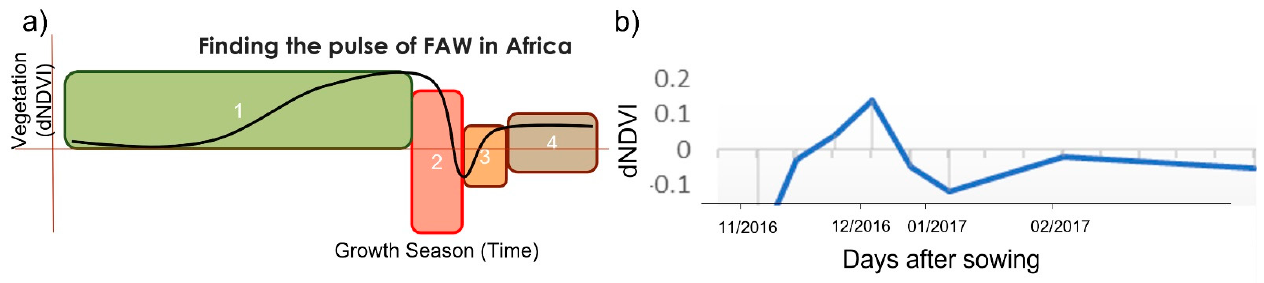
Figure 4. ( a ) Conceptual framework of the time series analyses that was expected through the four stages of maize response to the FAW. (1) The crop growth as normal, emergence, increased rate of growth until reaching a plateau at near full growth. (2) FAW infestation results in the loss of vegetative cover, marked as “negative growth.” (3) The negative values of the first derivative end with treatment or cob development (as the FAW will move to the cob during the maize reproductive phase). (4) The crop may recover and the FAW may attack again up until the maize reproductive phase-cob development, when subsequent FAW impacts will result in symptoms not observable by remote sensing techniques, being a somewhat hidden yield loss. ( b ) Exemplary actual Sentinel 2 NDVI time change first-derivative time series at a location of documented high FAW damage, according to FAMEWS. The satellite image analysis results using the GEE API from the preliminary data point of FAW infestation from the 2016–2017 maize field season where the most data points remained after cloud mask filtering at the pixel level.